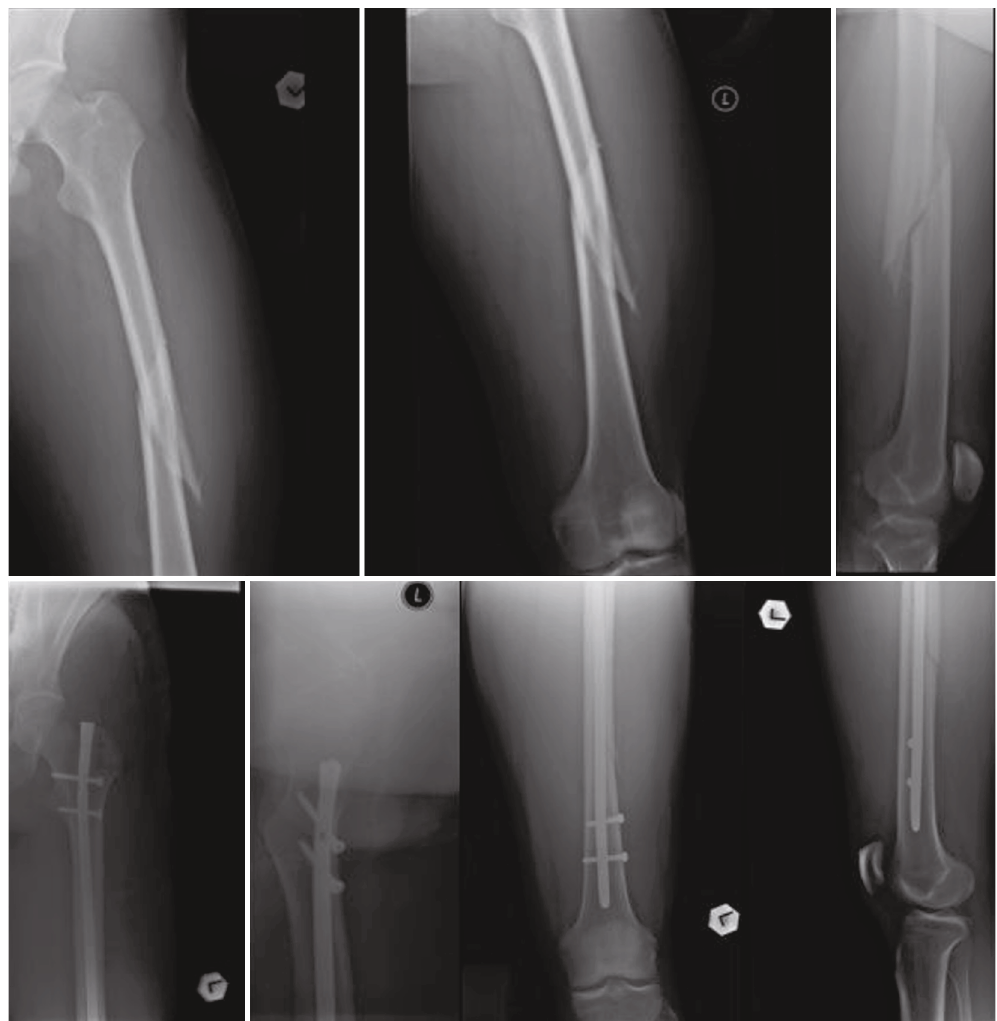
Figure 1: Patient A, a 28-year-old male patient with left-sided midshaft spiral femoral fracture before and after